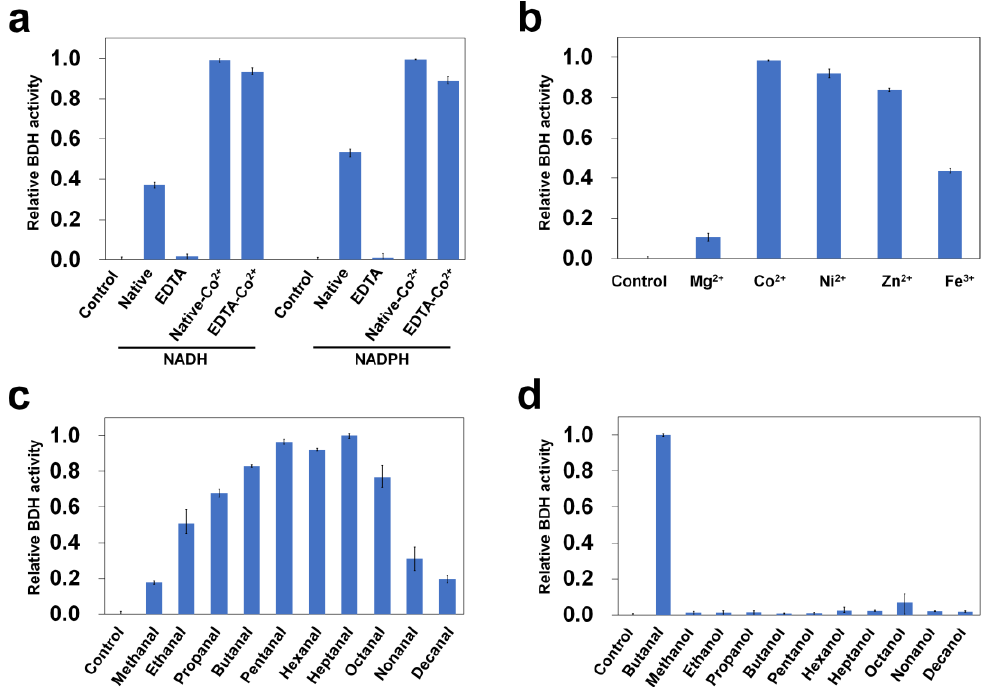
Figure 2. Butanol dehydrogenase activity of FnYqdH. ( a ) Effect of cofactors on enzyme activity of FnYqdH. ( b ) Effect of metal ions on enzyme activity of FnYqdH. Measurement of enzyme activity of FnYqdH toward the ( c ) aldehydes and ( d ) alcohols (the activity of butanal was defined as 100%). The graph represents the mean of three independent experiments, and error bars indicate the standard deviation.